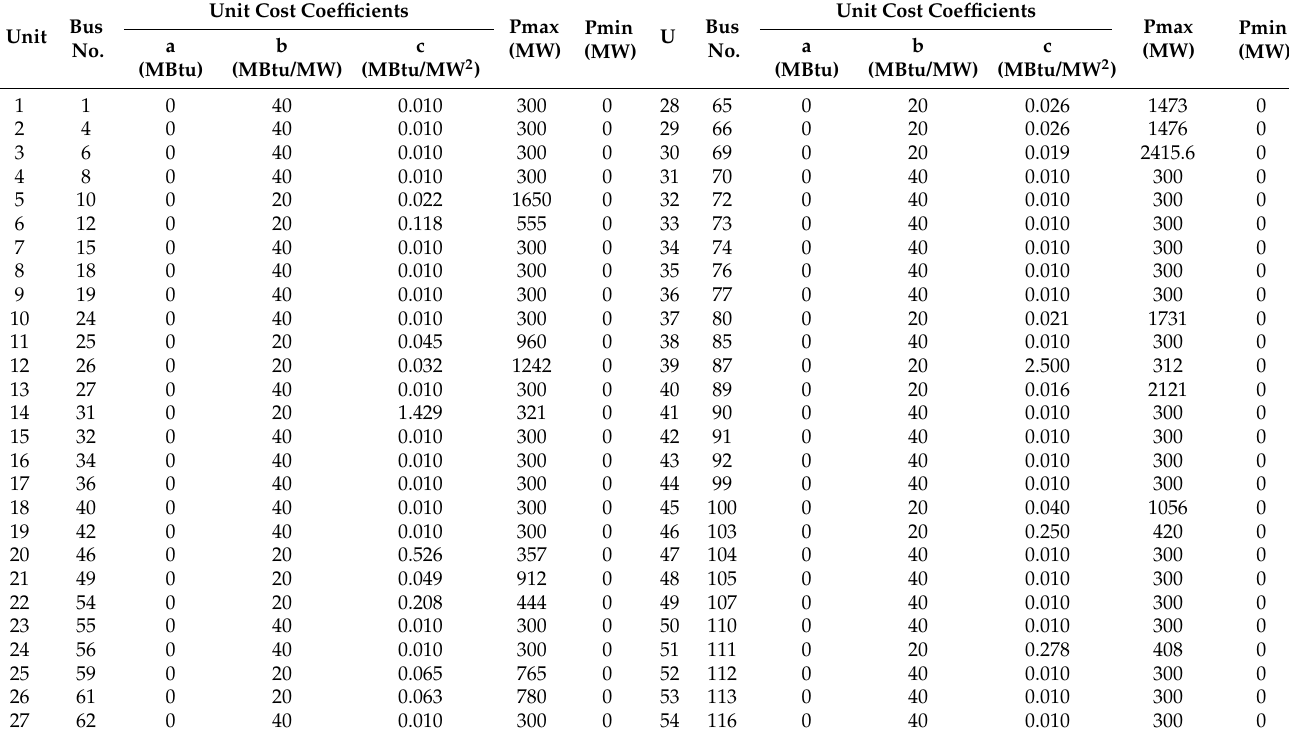
Table A4. Generator data of the modified IEEE 118-bus system.